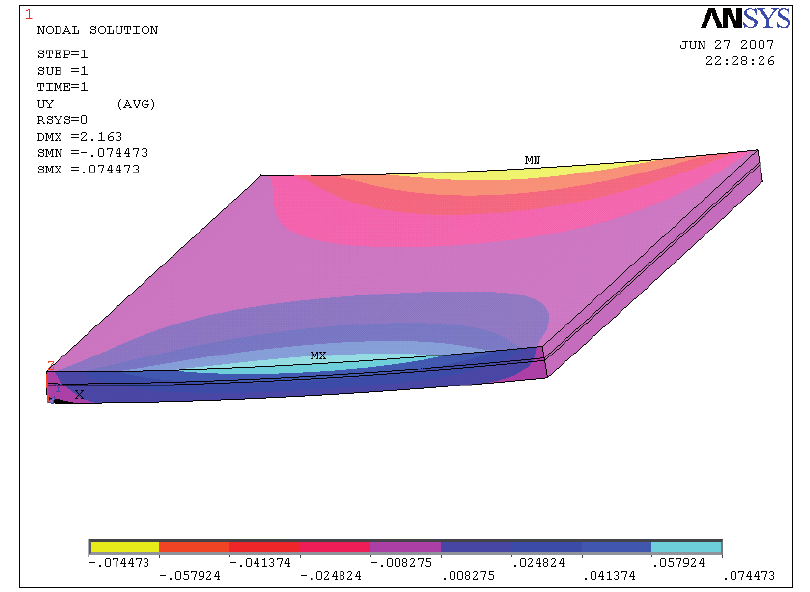
Fig. 8. Transversal shrinkage of raster scanning